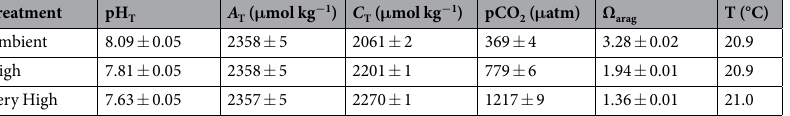
Table 1. Mean carbonate chemistry for each treatment during the 8-week experiment. The mean ± SE dissolved inorganic carbon ( C T ), partial pressure of CO 2 (pCO 2 ), and the saturation states of aragonite (Ω arag ) were calculated from pH T , total alkalinity ( A T ), and temperature